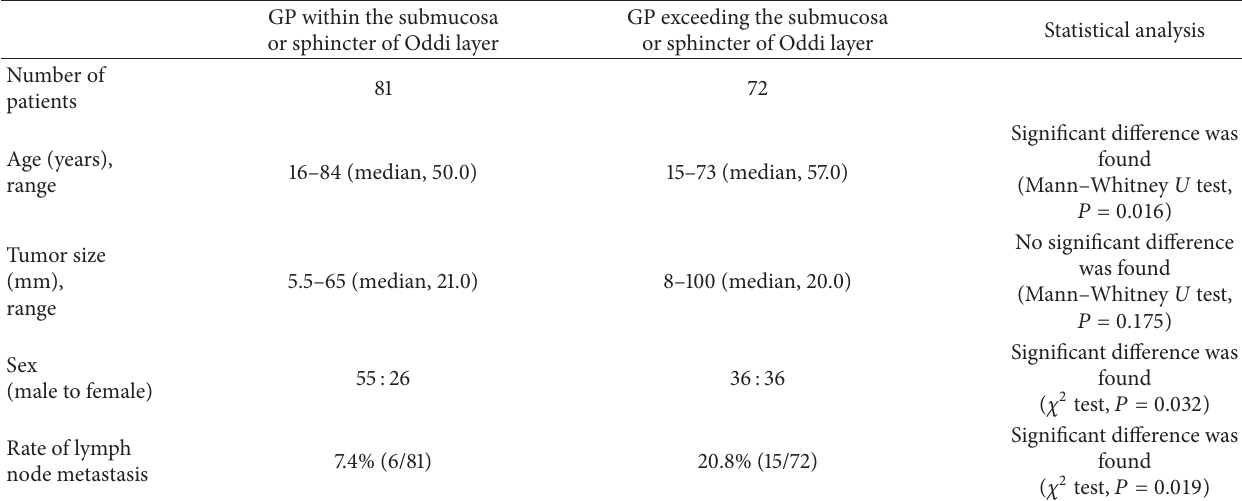
Table 3: Comparison of clinicopathological data between patients with gangliocytic paraganglioma (GP) within and those with GP exceeding the submucosa or sphincter of Oddi layer.